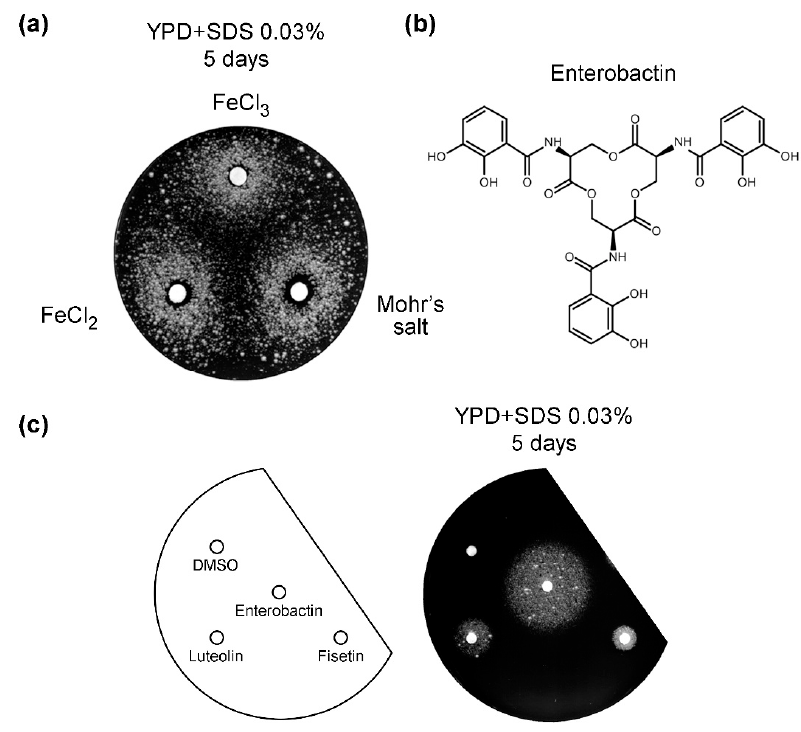
Figure 6. Iron salts and enterobactin restore growth of vps13 ∆ cells on SDS plates. ( a ) The vps13 ∆ strain was plated on YPD + SDS 0.03%. Iron salts (FeCl 3 , FeCl 2 , and Mohr’s salt Fe(NH 4 ) 2 (SO 4 ) 2 ) were applied at 10 µ L of 1 M solution per spot. Plates were incubated for 5 days. ( b ) Structure of enterobactin. ( c ) The vps13 ∆ strain was plated on YPD + SDS 0.03%. Enterobactin and flavonoids were applied at 10 µ g per spot. Luteolin and fisetin were used as positive controls, and DMSO as negative control. Plates were incubated for 5 days.